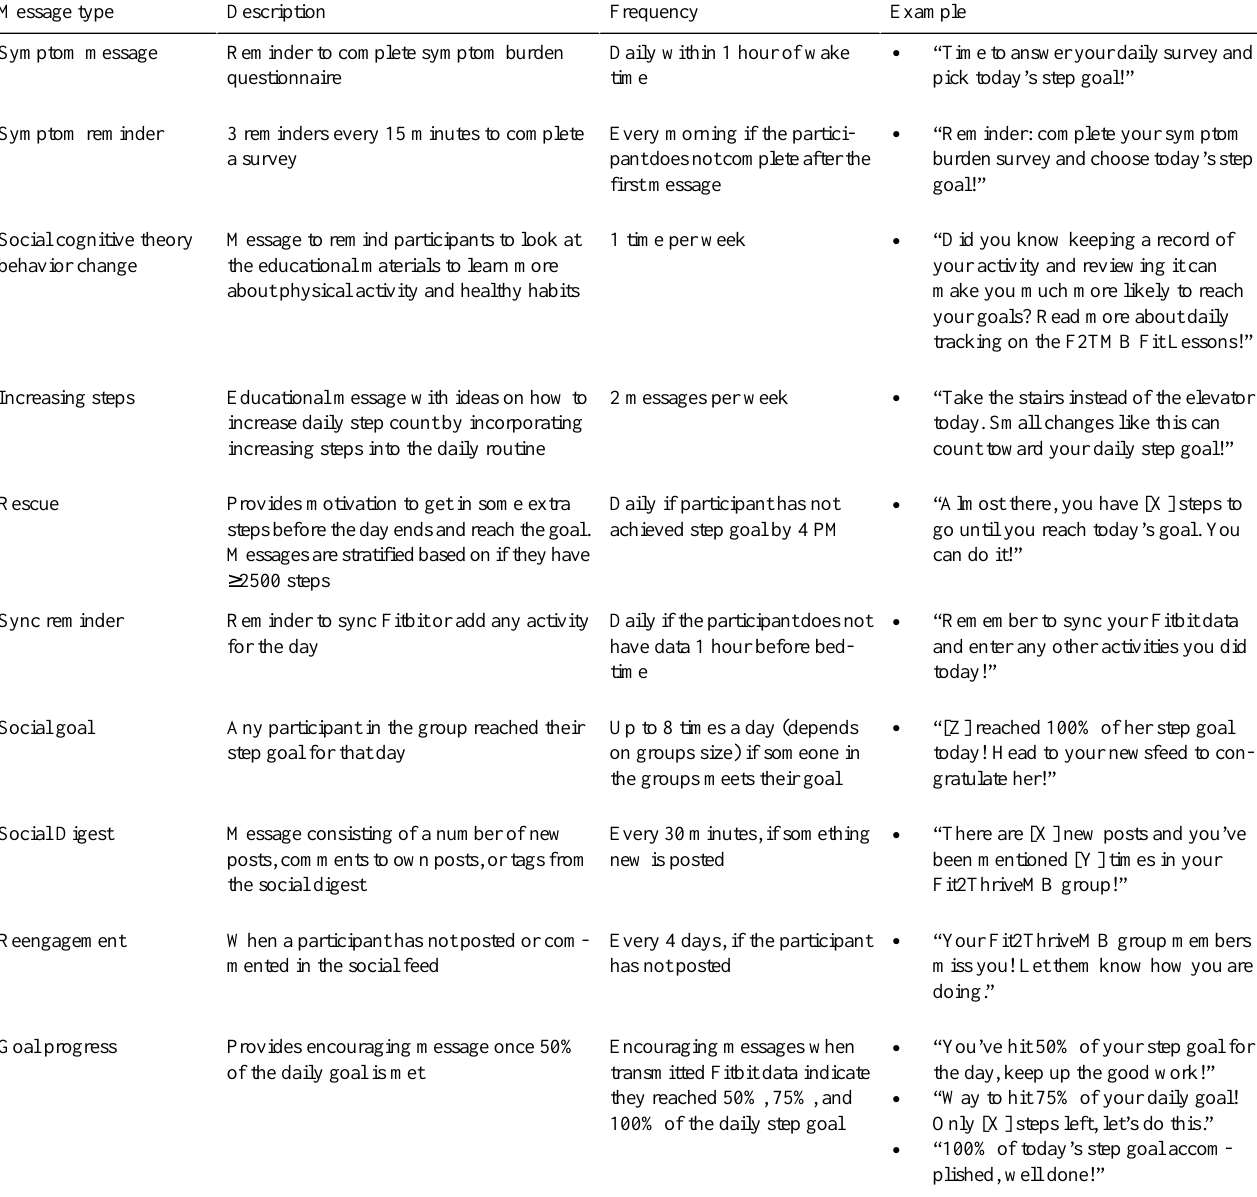
Table 4. Fit2ThriveMB app notification types and